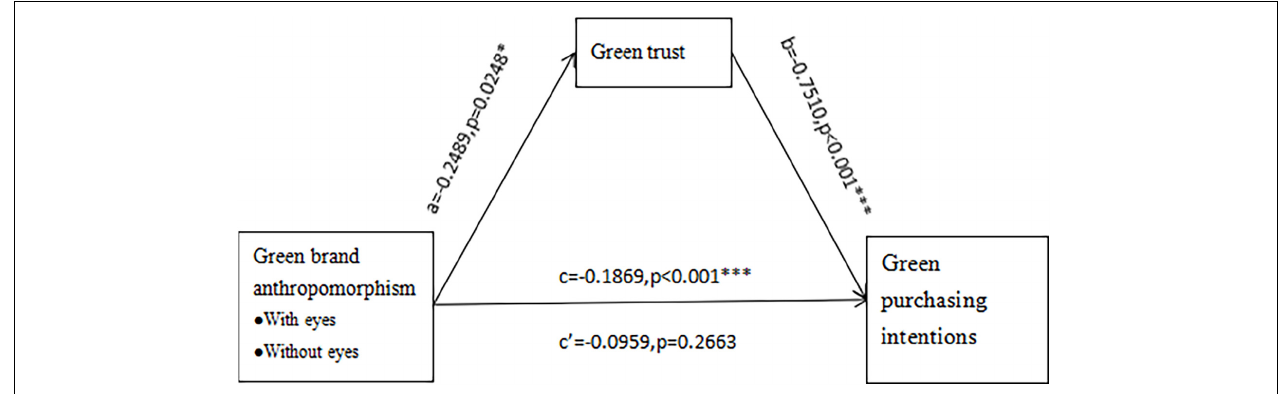
FIGURE 5 | Mediation effect of green trust. * p < 0.05, *** p <